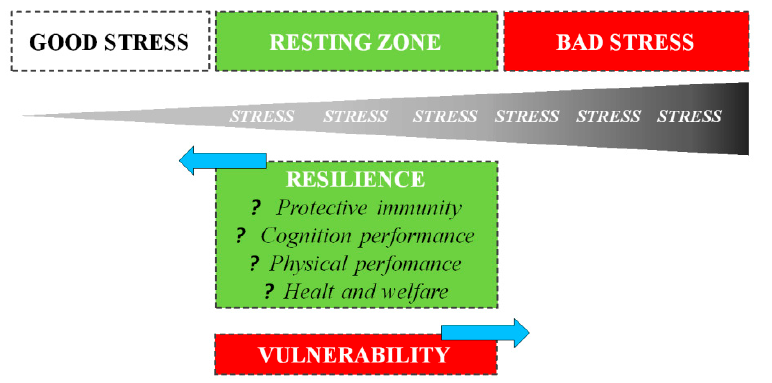
Figure 2. Staying on the good side of the stress spectrum to maintain health, one needs to optimize GOOD stress, maximize the RESTING ZONE, and minimize BAD stress. A resting zone exists between bad (harmful) and good (beneficial) stress, and the efficiency with which an organism returns to its resting zone following stress depends on its